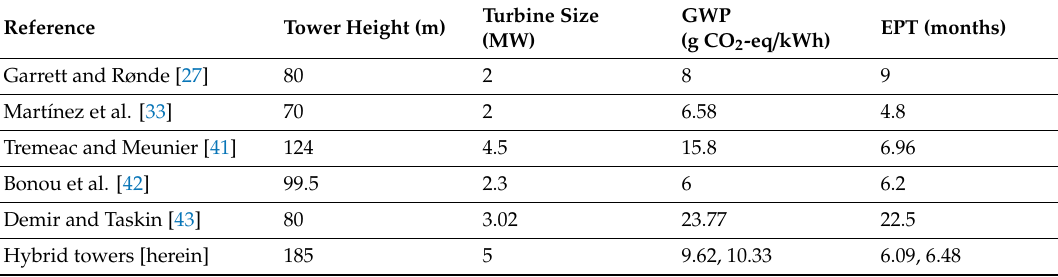
Table 8. Comparison with the literature